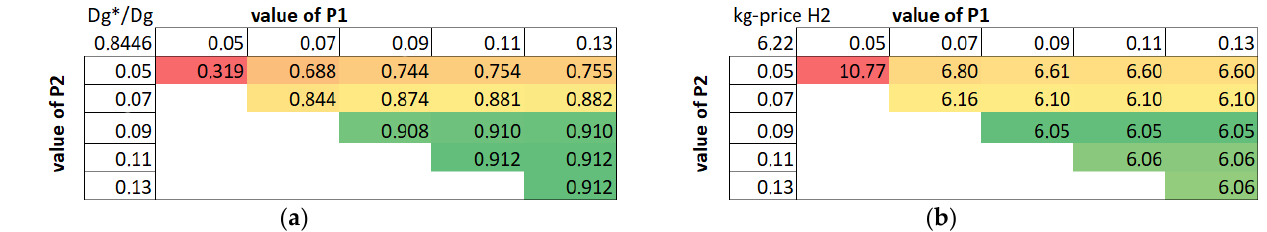
Figure 7. Influence of import price levels P 1 and P 2 on ( a ) supply security and ( b ) hydrogen price.